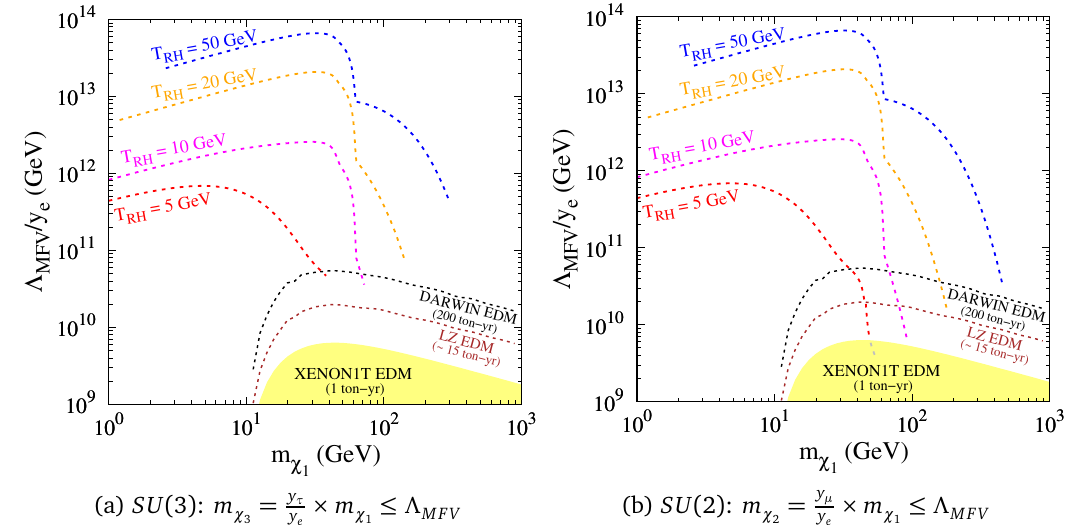
Figure 4: Results from relic density constraints and direct detection experiments: the contours correspond to the parameter space exactly reproducing observed relic density, for given reheating temperatures. The yellow shaded region is ruled out by current bounds from XENON1T, and the future projections of constraints from DARWIN and LZ are also